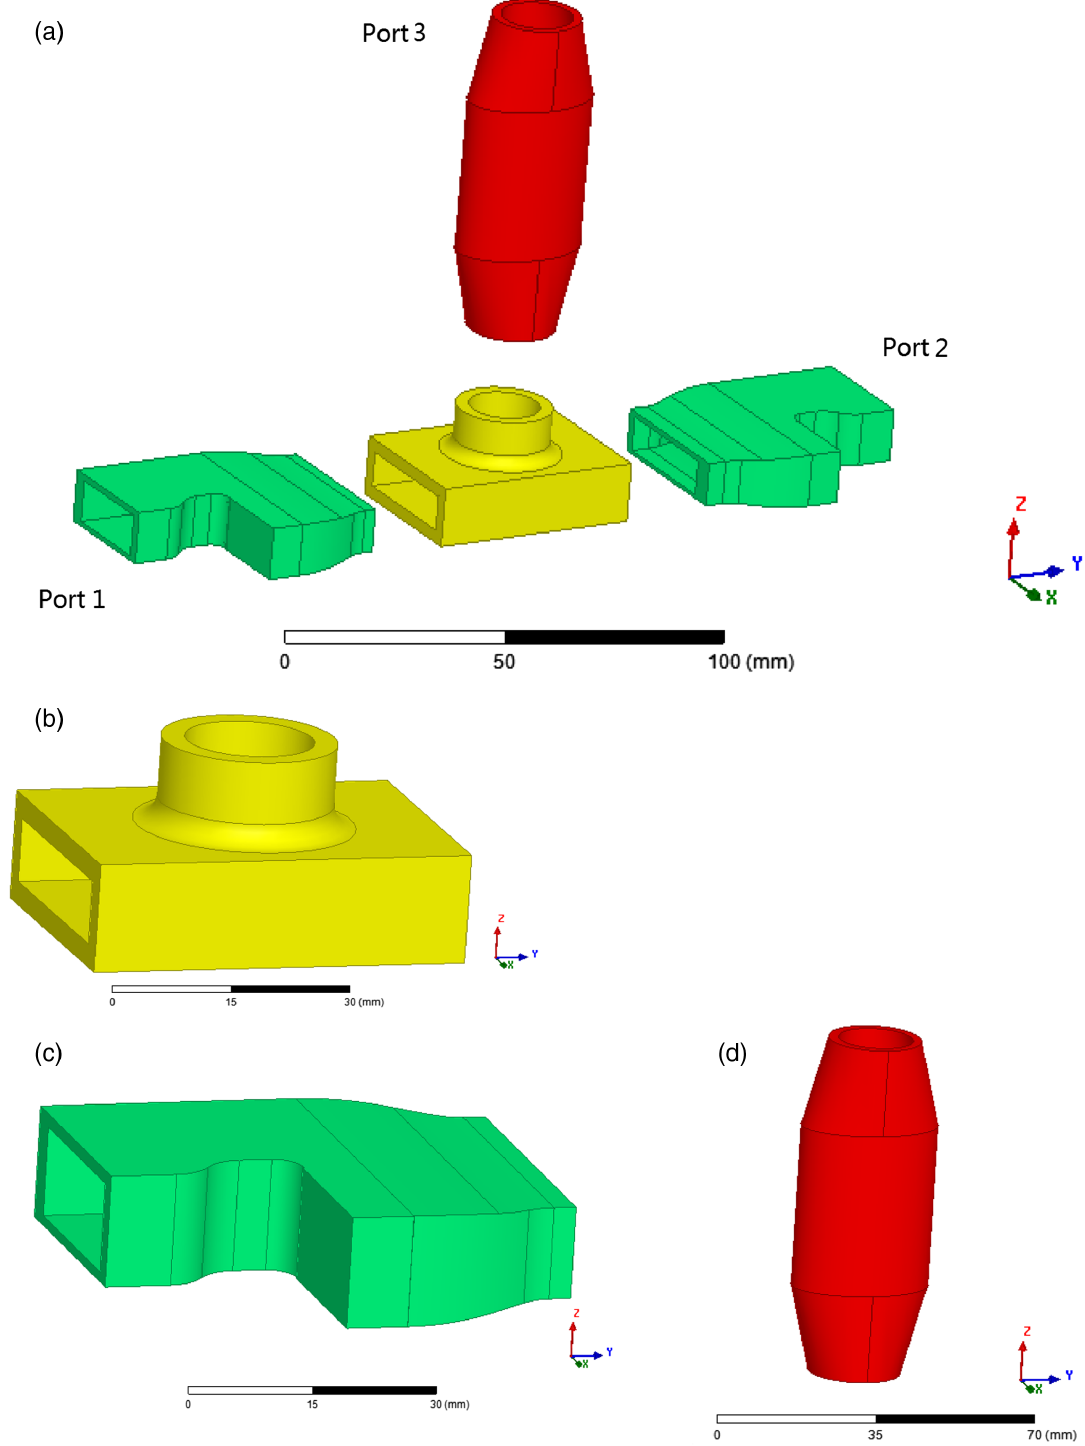
FIG. 1. Mechanical configurations of this circular polarizer. A is the full assembly of the polarizer. B is the rf mode converter in the center (yellow). C is configuration of the rf mode converter on both ends (green). D is the adjuster which is added to correct the phase and amplitude